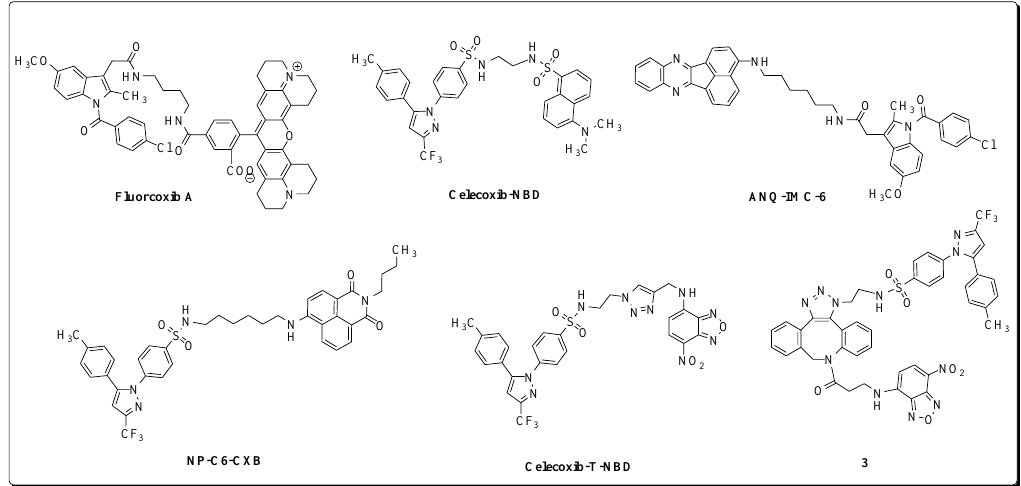
Figure 2. Selected examples of fluorescent probes for COX-2 imaging.